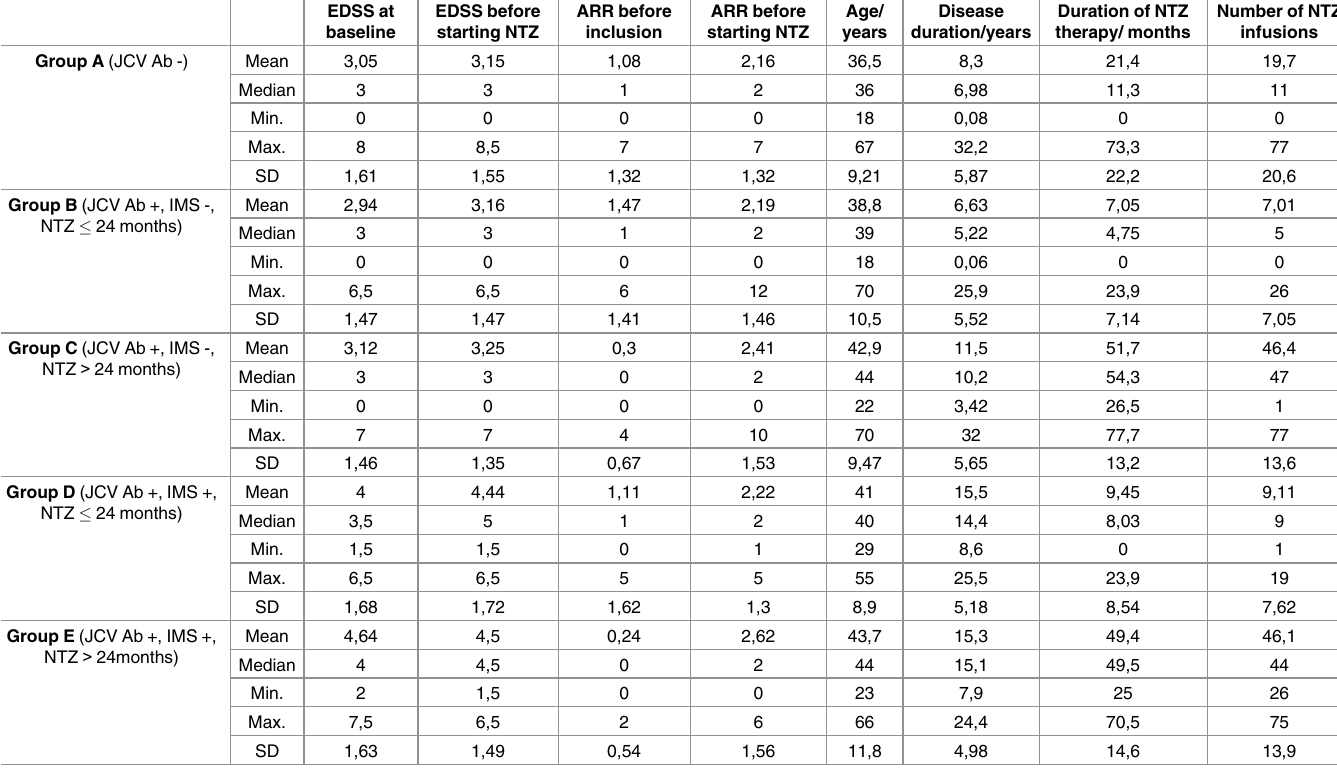
Table 3. Disease-related data of patients of the groups A-E at baseline. ARR = annualized relapse rate; EDSS = Expanded DisabilityStatus Scale; IMS + /- = prior / no prior use of immunosuppressants; JCV Ab + /- = positive / negative serostatusfor anti-JCV antibodies;NTZ > / (cid:20) 24 months = natalizumab treatment longer/ less than 24